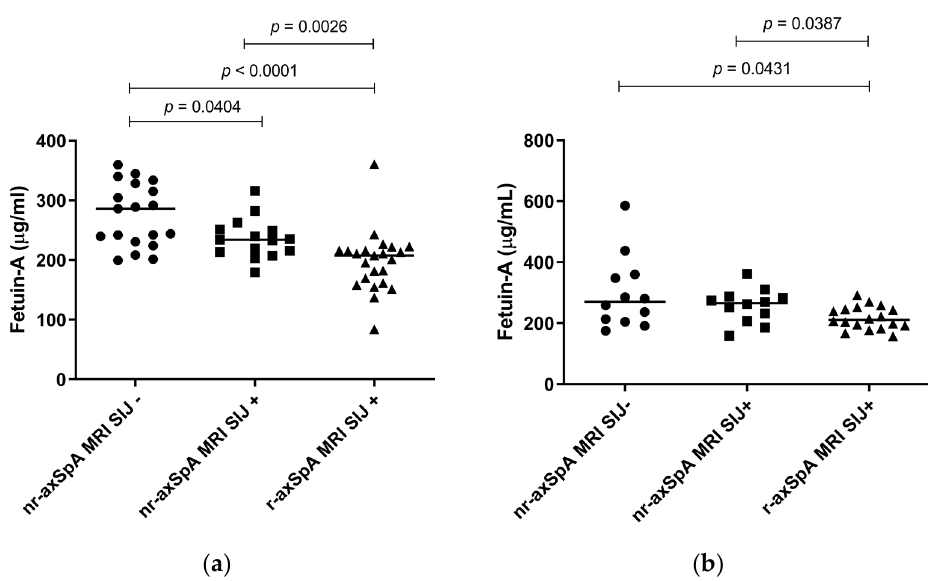
Figure 1. Association of fetuin-A at T0 ( a ) and at T24 ( b ). Fetuin-A levels at T0 and T24 were positively associated (r = 0.3, p = 0.06) (Table S4). At T0, fetuin-A was significantly higher in non-smokers compared with smokers (237.1 (210.8–288.8) vs. 213.4 (182.1–223.1), respectively, p = 0.01); in patients with heel enthesitis compared with those without (232 (208.6–262.4) vs. 207.4 (182.1–214.8), respectively, p = 0.03) and with a family history of SpA compared with no family history (234.7 (215.5–287.6) vs. 211 (199.3–242.6), respectively p = 0.04). Fetuin-A T0 levels were significantly lower in patients with radiographic sacroiliitis compared to those with no sacroiliitis: 207.9 (181.7–215.9) vs. 239.9 (216.4–287.6), respectively, p < 0.001 (Table S3). Also, fetuin-A T0 levels negatively correlated with mNY at T0 (r = − 0.59, p < 0.001) and SPARCC spine at T0 (r = − 0.31, p = 0.02) (Table S4). At T24, fetuin-A was significantly lower in males (males 204.7 (180.1–245) vs. females 262.9 (232.5–285.7), p < 0.001), in patients who had elevated CRP or ESR at T0 (232.5 (186.5–259.2) vs. 261.1 (211.2–317), p = 0.04), and in patients with radiographic sacroiliitis at T0 (207.6 (182.5–246.5) in those with sacroiliitis vs. 261.1 (210.2–286.6) in those without, p = 0.03) (Table S3). Fetuin-A levels at T24 correlated with the age at CBP onset (r = 0.42, p = 0.01) (Table S4) and negatively correlated with indices of radiographic damage both at T0 (mNY: r = − 0.38, p = 0.01; SPARCC SIJ: r = − 0.33, p = 0.04, SPARCC spine: r = − 0.31, p = 0.05) and at T24 (mNY: r = -0.39, p = 0.01) (Table S4). 2.3. Factors Associated with Radiographic Sacroiliitis at T0 (Univariate Analysis and Multivariate Logistic Regression) Characteristics of the patients according to the presence of radiographic sacroiliitis are reported in Table 1 together with results of univariate tests. Twenty-one patients in the cohort (38.8%) presented radiographic sacroiliitis at T0. Patients with radiographic sacroiliitis had lower fetuin-A levels ( p < 0.001), BASDAI ( p = 0.03) and MASES ( p = 0.04) at T0. Heel enthesitis was less frequent in patients with radiographic sacroiliitis at T0 ( p = 0.04) (Table 1). Variables included in the multivariate logistic regression analysis were male sex, smoking, heel enthesitis at T0, fetuin-A levels at T0, BASDAI, and MASES at T0. No variable was excluded because of collinearity. The regression model was statistically significant, X2 (df = 6, N = 57) 15.61, p = 0.016 (Table 2). The model explained 32.7% of the variance in radiographic sacroiliitis and correctly classified 63.2% of cases. Only increasing fetuin-A levels at T0 were significantly associated with a reduction in the